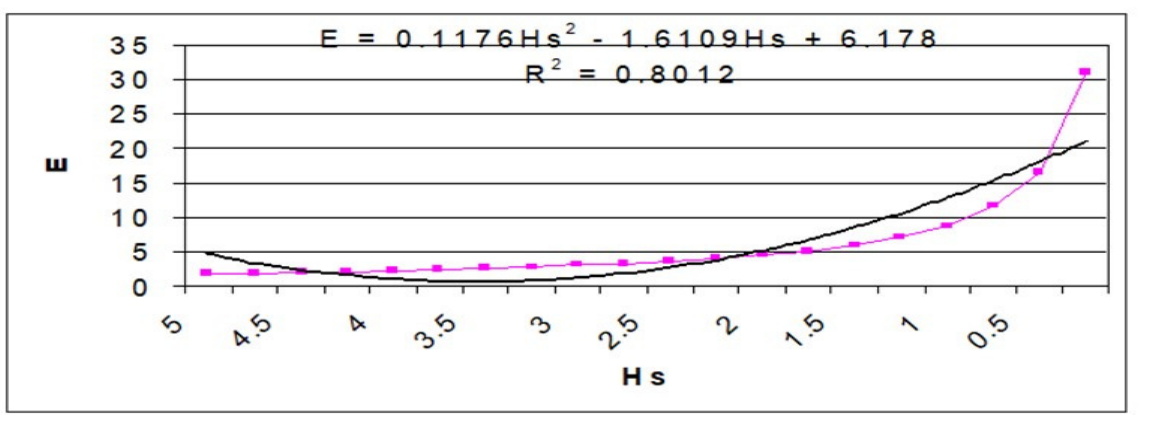
Fig. 2: Graphical Representation of Hs vs %